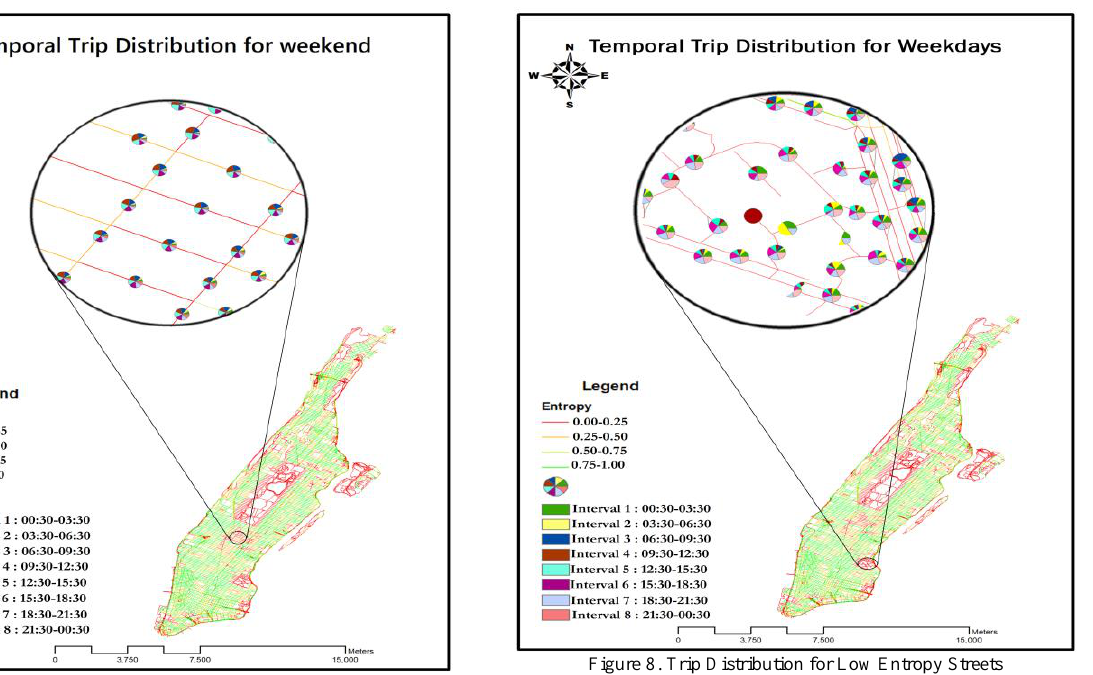
Figure 7. Trip Distribution for Low Entropy Streets